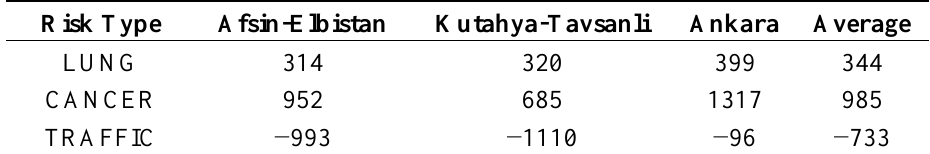
Table 8. Differences in WTP for Different Risk Types (TL)